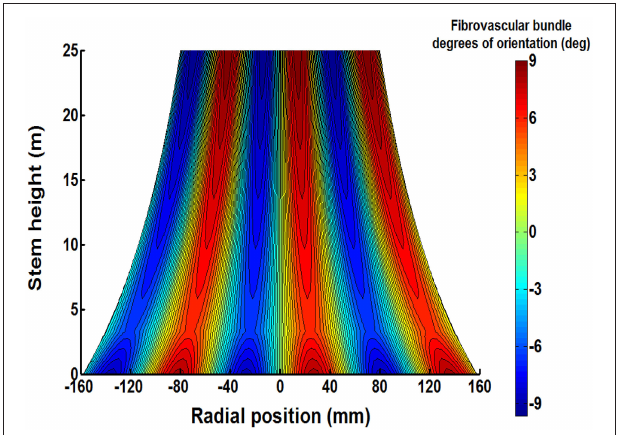
FIGURE 8 | The proposed typical triple helix distribution of tangential fibrovascular bundle degrees of orientation is shown on the plane of symmetry of a characteristic senile coconut palm 25m stem height. The cocowood structure in the figure shows an apparent pattern of fibrovascular bundles with a maximum deviation of 9.15 ◦ . Note also a different fibrovascular bundle configuration up to a stem height of